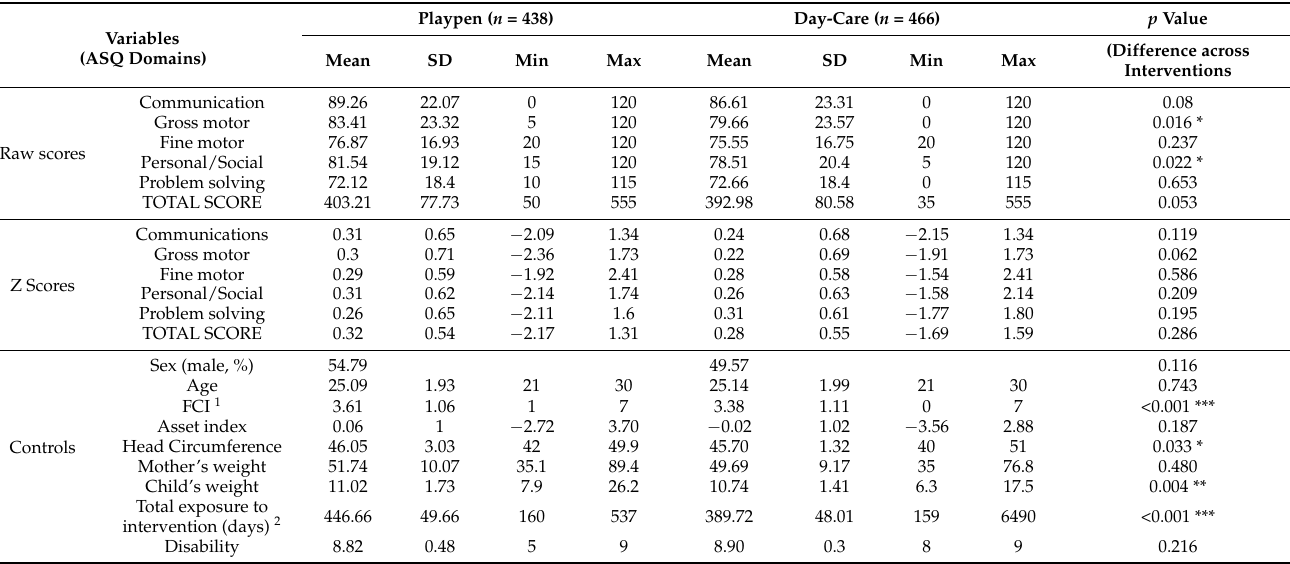
Table 2. Sample characteristics and differences between children in playpen and day-care interven- tions on the ages and stages questionnaire in round 2 (426 days post-intervention on